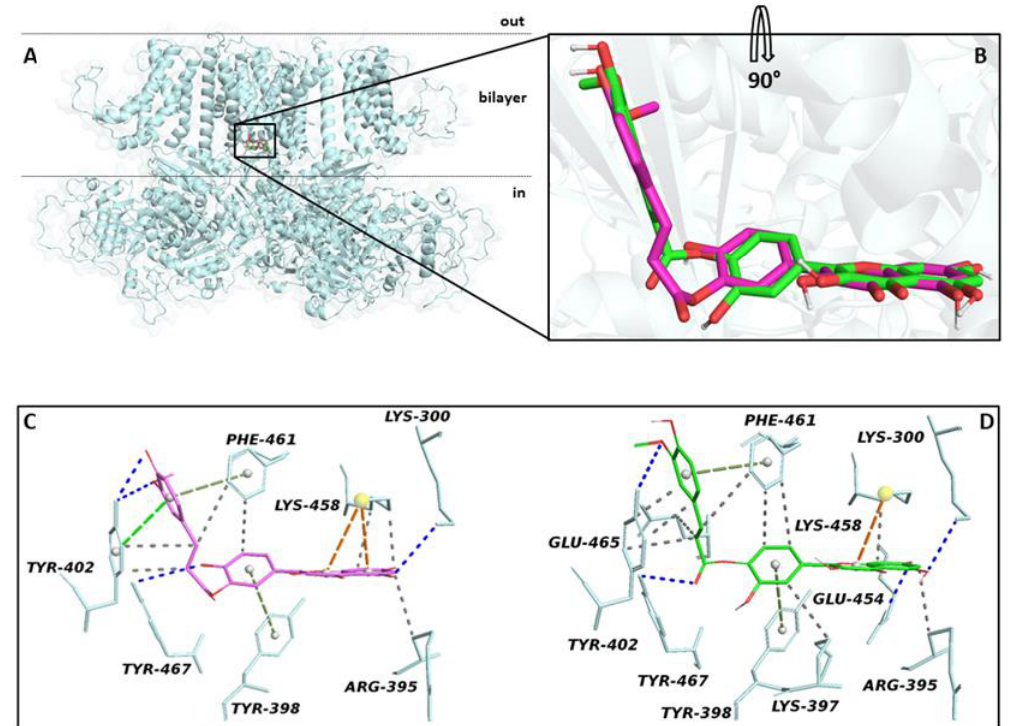
Figure 1. K Ca 1.1 channel/compounds 1 and 2 docked pose overview. ( A ) The K Ca 1.1 channel is shown as a transparent cyan surface-cartoon while the binding pocket is shown in cyan surface. The ligands are reported in green sticks and balls. The membrane bilayer is delimited by two black dotted lines. ( B ) Zoom in of the compounds within K Ca 1.1 channel binding pocket. ( C , D ) K Ca 1.1 channel/compounds 1 and 2 interaction network. The binding residues are colored in cyan sticks and balls. Hydrogen bonds, hydrophobic interactions, π -stacking and π -cationic interactions are represented as blue, grey, green and orange dotted lines, respectively.